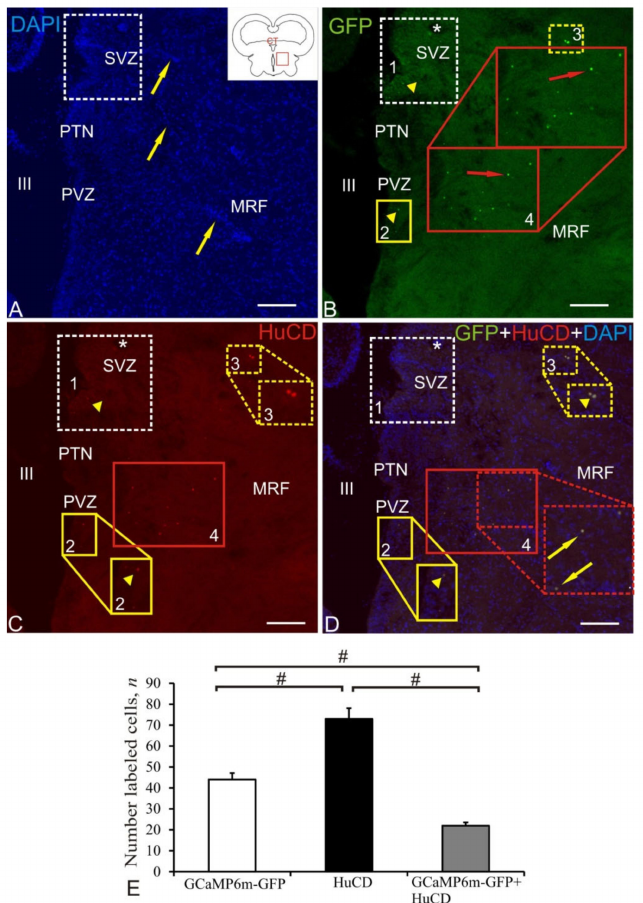
Figure 4. Z-stacks representing HuCD immunolabeling in the postcommissural region of the basal mesencephalon of juvenile chum salmon, O. keta , at 1 week after a single injection of recombinant AAV into the mesencephalic tegmentum region. ( A ) DAPI staining, the pictogram shows the post- commissural region of the basal mesencephalon (outlined by the red rectangle), the dashed rectangle outlines the dorsal clusters, the nuclei are indicated by yellow arrows, PVZ—the periventricular zone, SVZ—the subventricular zone, PTN—the posterior tuberal nucleus, the MRF—mesencephalic reticular formation, III—hypothalamic ventricle. ( B ) Expression of GFP in cells (red arrows), dorso- medial posterior tuberal group (population № 1) (outlined by white dotted line), GFP+ granules (yellow arrowheads), perventricular aggregation (population № 2), an asterisk shows a GFP- nucleus aggregation, individual GFP+ cells in MRF, (population № 3), an aggregation of intensely fluores- cent cells (population № 4) is outlined by red square, the inset shows a higher magnification. ( C ) Immunofluorescence of HuCD, designation as in B, neurons of populations № 2 and 3 are shown at higher magnification (inset). ( D ) Superposition of three DAPI/GFP/HuCD staining channels, showing areas of GFP/HuCD colocalization in neurons (yellow arrows), neurons of populations № 2, 3, and 4 are shown at higher magnification (inset). Laser scanning confocal microscopy. Scale bar: 200 µ m. ( E ) Results of ANOVA analysis showing the comparative distribution of labeled cells and nuclei (M ± SD, where M is the mean and SD is the standard deviation) in the postcommissural area of the chum salmon. Significant intergroup differences (# < 0.05) were found between the groups of GCaMP6m-GFP+ and HuCD+ cells, GCaMP6m-GFP+ and GCaMP6m-GFP+/HuCD+ cells, and between the groups of HuCD+ and GCaMP6m-GFP+/HuCD+ cells ( n = 5 in each